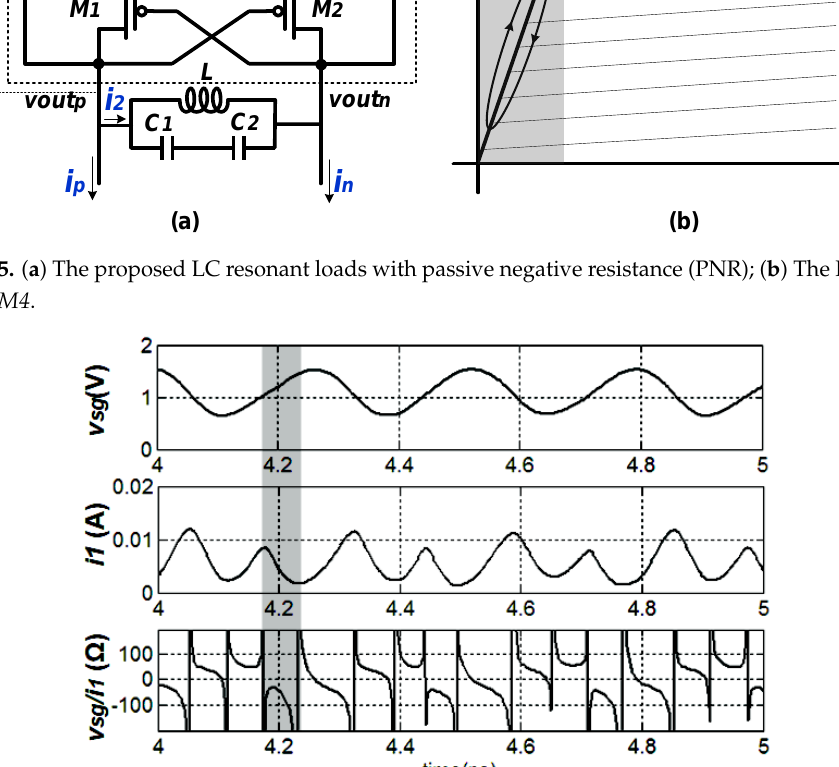
Figure 6. The transient simulation results of 𝑣 𝑠𝑔 , 𝑖 1 and output resistance.